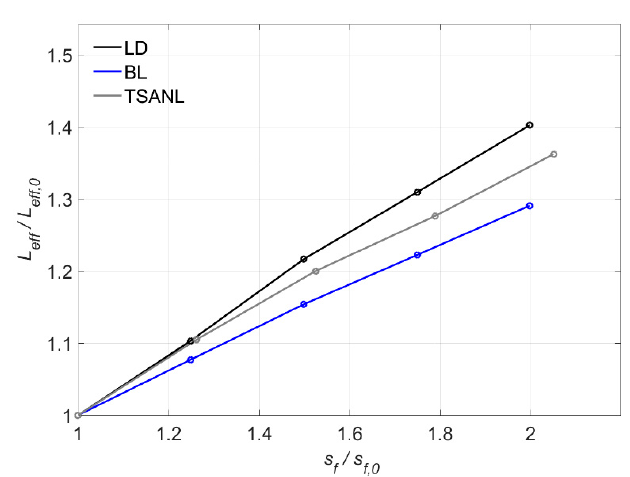
Figure 20. Variation of L eff versus s f .